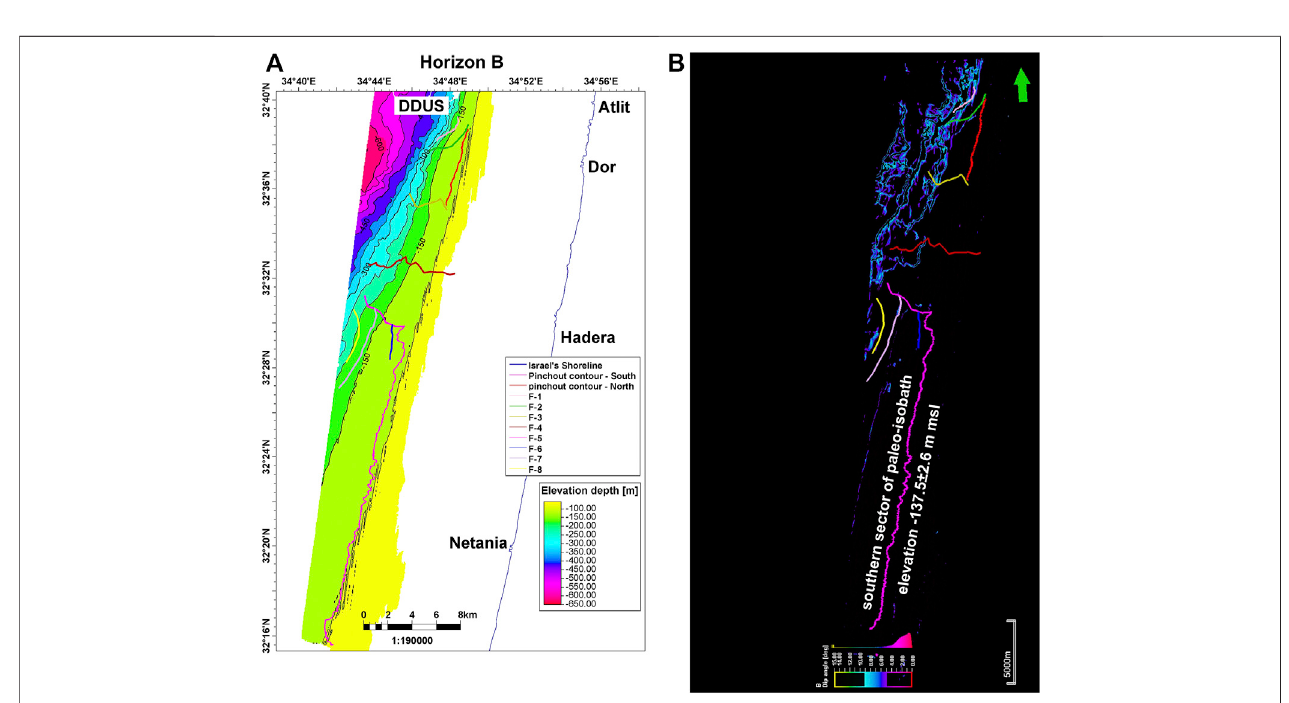
FIGURE 6 | Seismic mapping of Horizon B, (A) Topographic map of Horizon B; (B) Dip angle map of Horizon B.